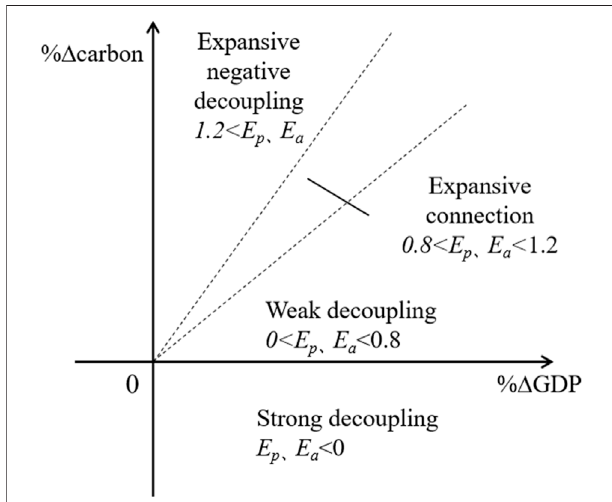
FIGURE 1 | Categories of carbon emission decoupling in